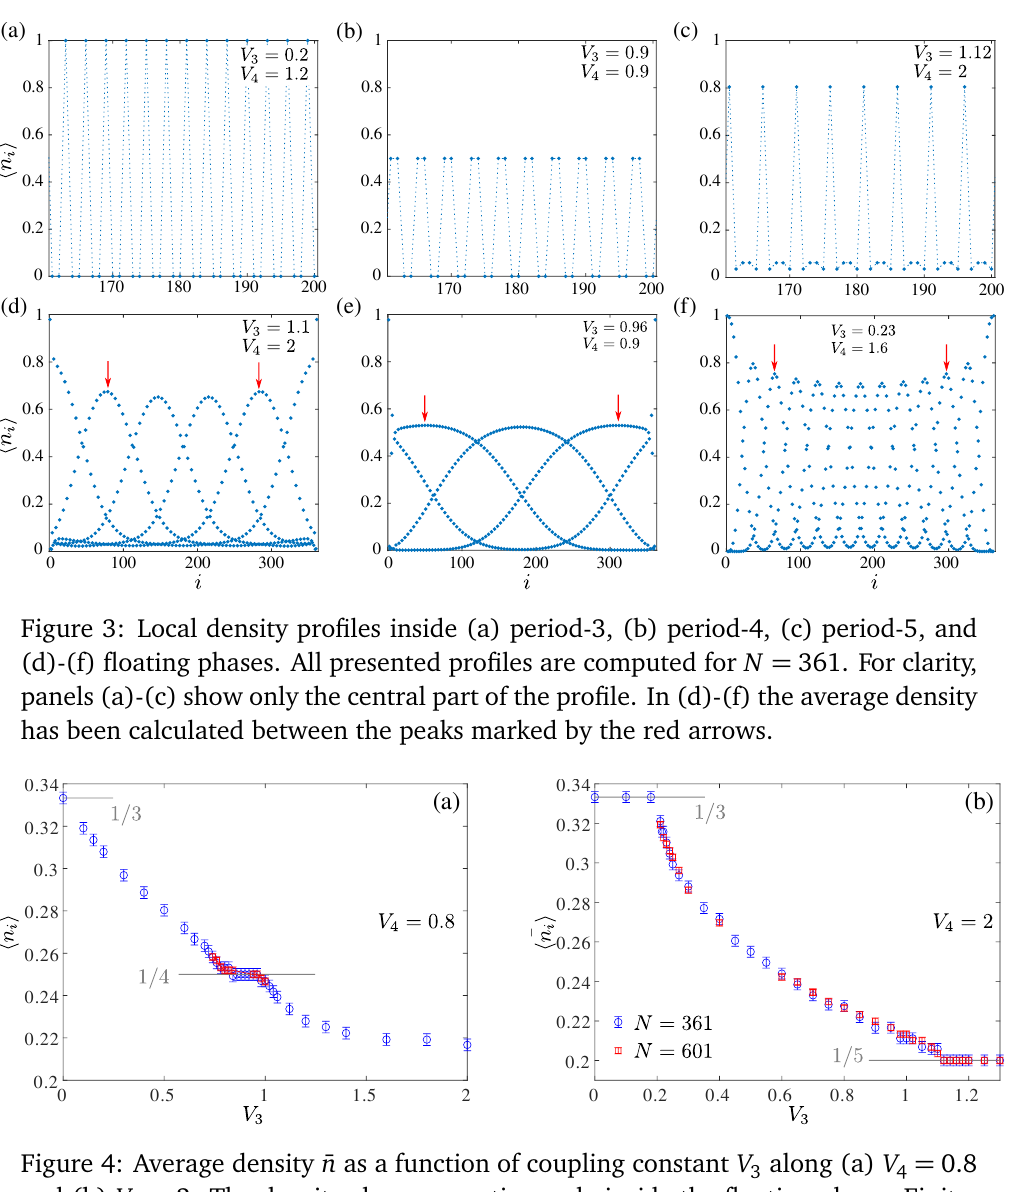
Figure 4: Average density ¯ n as a function of coupling constant V = 2. The density changes continuously inside the floating phase. Finite- and (b) V 4 size corrections are reflected in errorbars and are equal to 1 / N . (a) A plateau at 1 / 4 corresponds to the ordered period-4 phase. In (b) the density interpolates between the period-3 and period-5 phases through the floating phase. The blue and red data points correspond to system sizes N = 361, N = 601 respectively (and analogously in subsequent